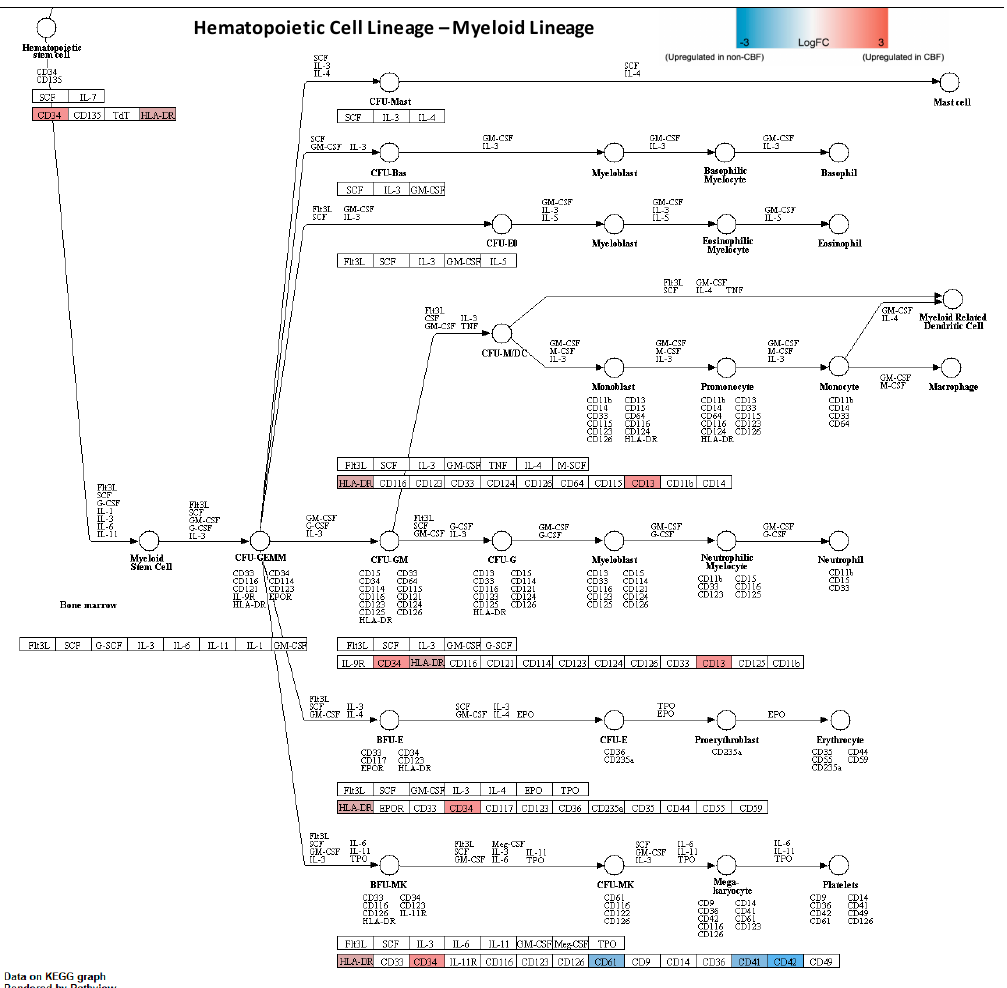
Figure 3. KEGG Pathview of hematopoietic cell linage of significant DEPs in CBF AML compared to non-CBF AML. Pathview analysis demonstrated majority of significant DEPs involved in the myeloid lineage differentiation. Proteins are indicated as significantly overexpressed in CBF AML (red), unchanged (gray), or overexpressed in non-CBF AML (blue). ANPEP also known as CD13 ; ITGA2B as CD41 ; GP9 as CD42a ; GP1BA as CD42b ; and ITGB3 as CD61.